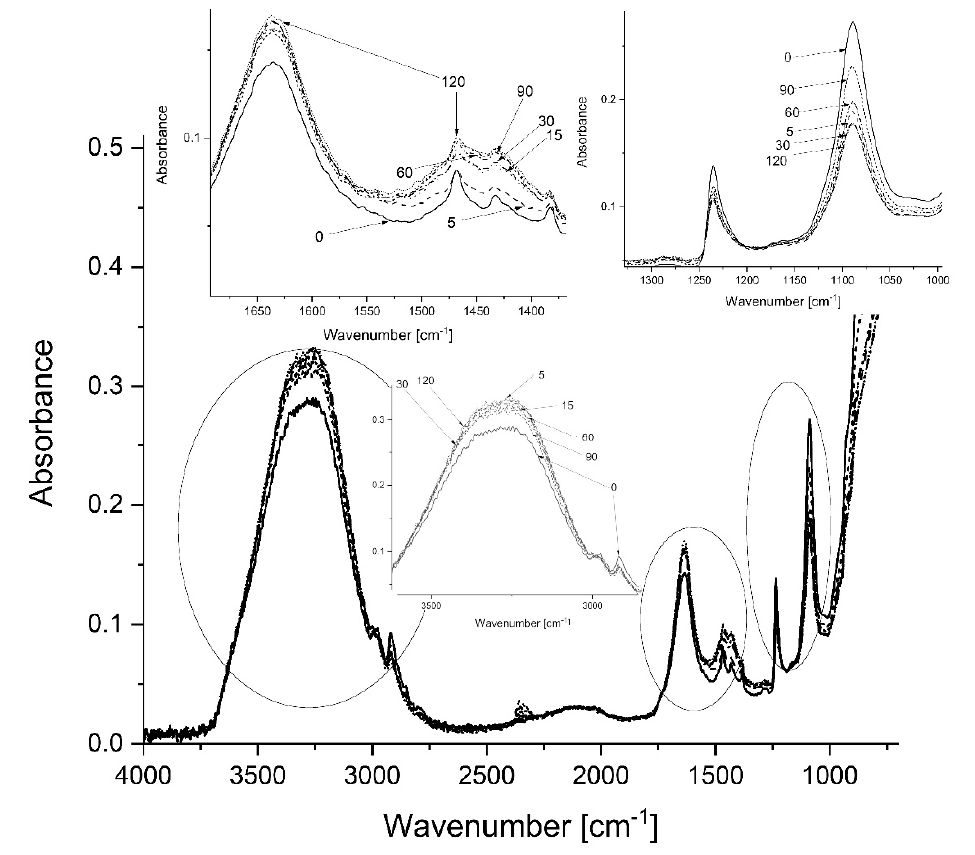
Figure 2. Fourier transformation infrared-attenuated total reflectance (FTIR-ATR) spectra of deionized water GP treated under methane for 0 to 120 min.